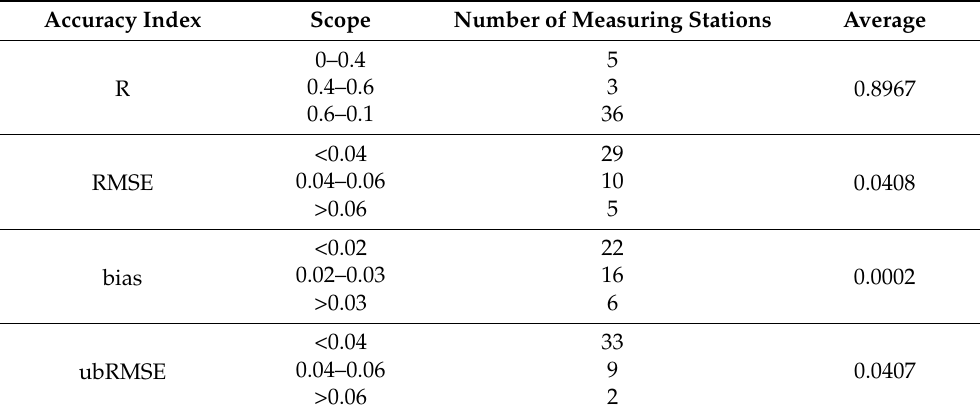
Figure 6. ( a ) Scatterplot of random sampling retrieval for the whole dataset; ( b ) Scatterplot of the test set data (15 February 2014–1 March 2014) for 44 modeling stations, providing Pearson correlation coefficients R, RMSE, bias, and ubRMSE. Table 3. Accuracy statistics of modeled measurement stations including R, RMSE, bias, and ubRMSE.